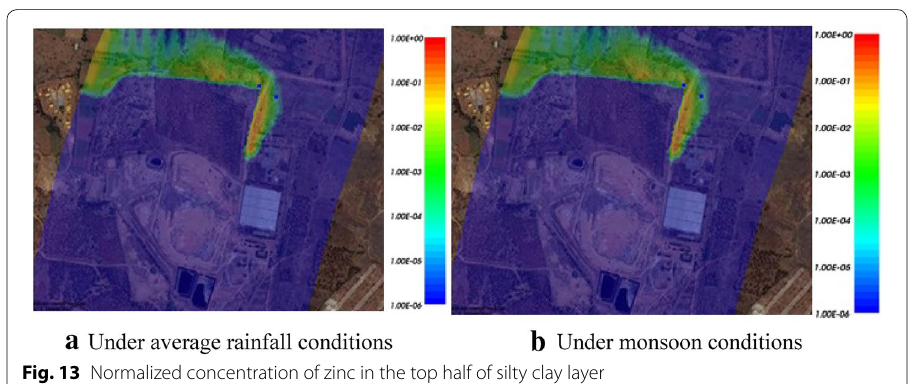
Fig. 13 Normalized concentration of zinc in the top half of silty clay layer